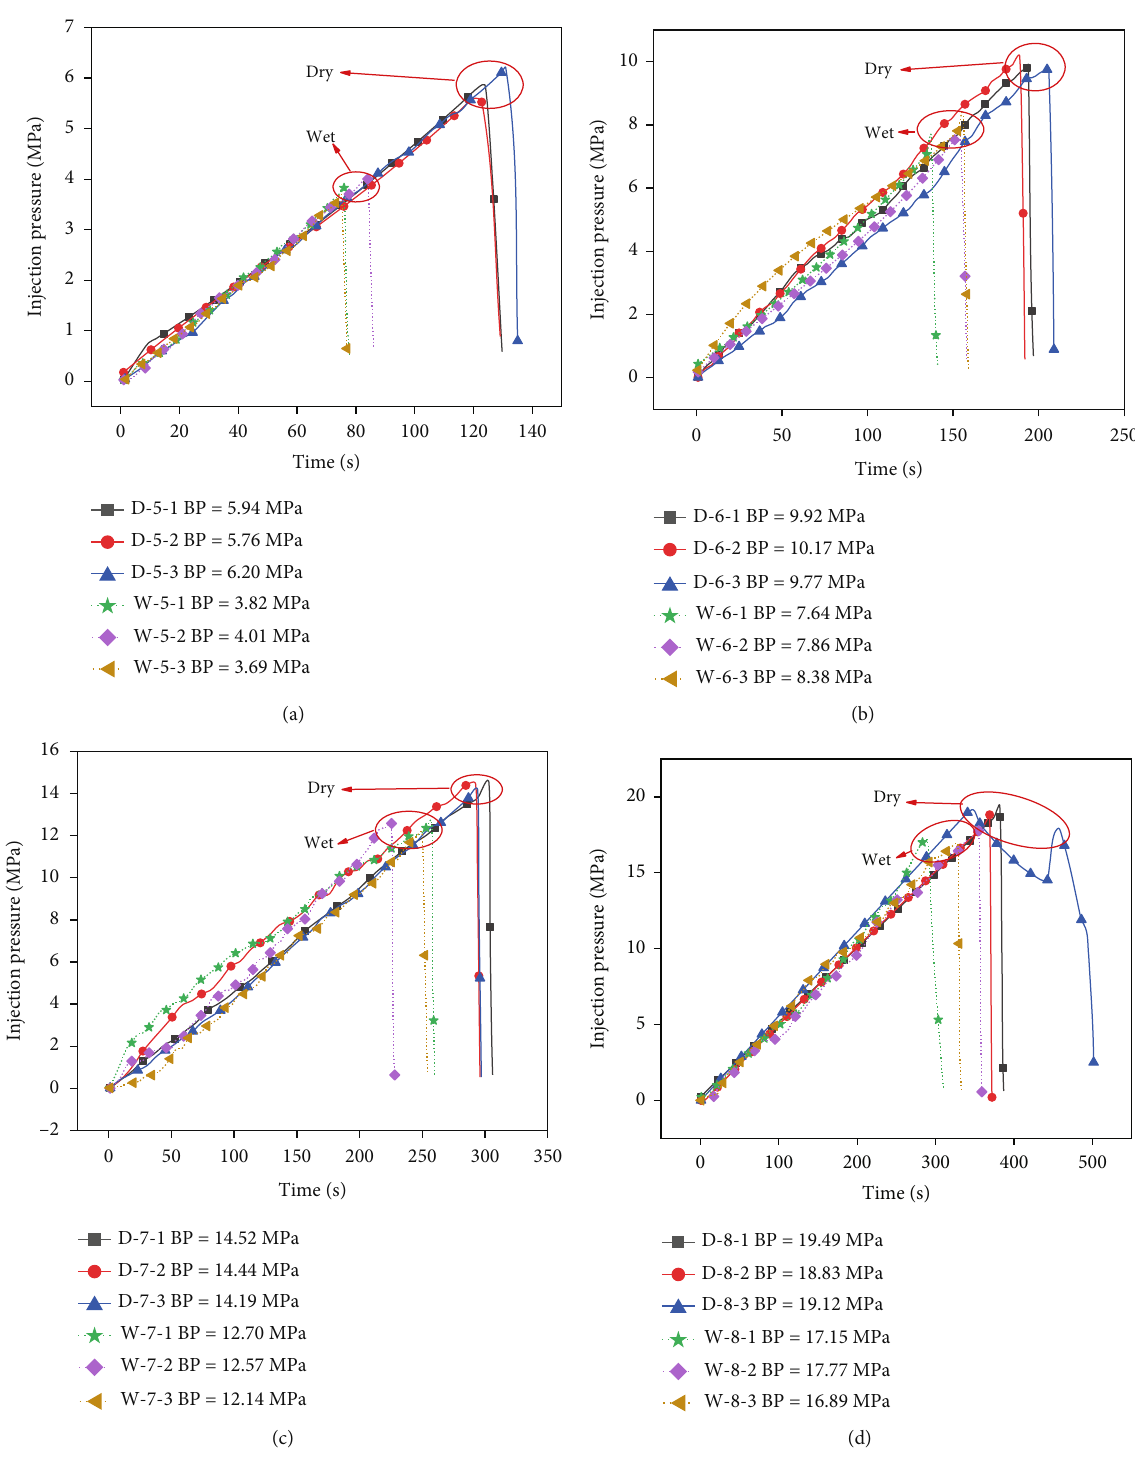
injection under di ff erent con fi ning pressures: 2